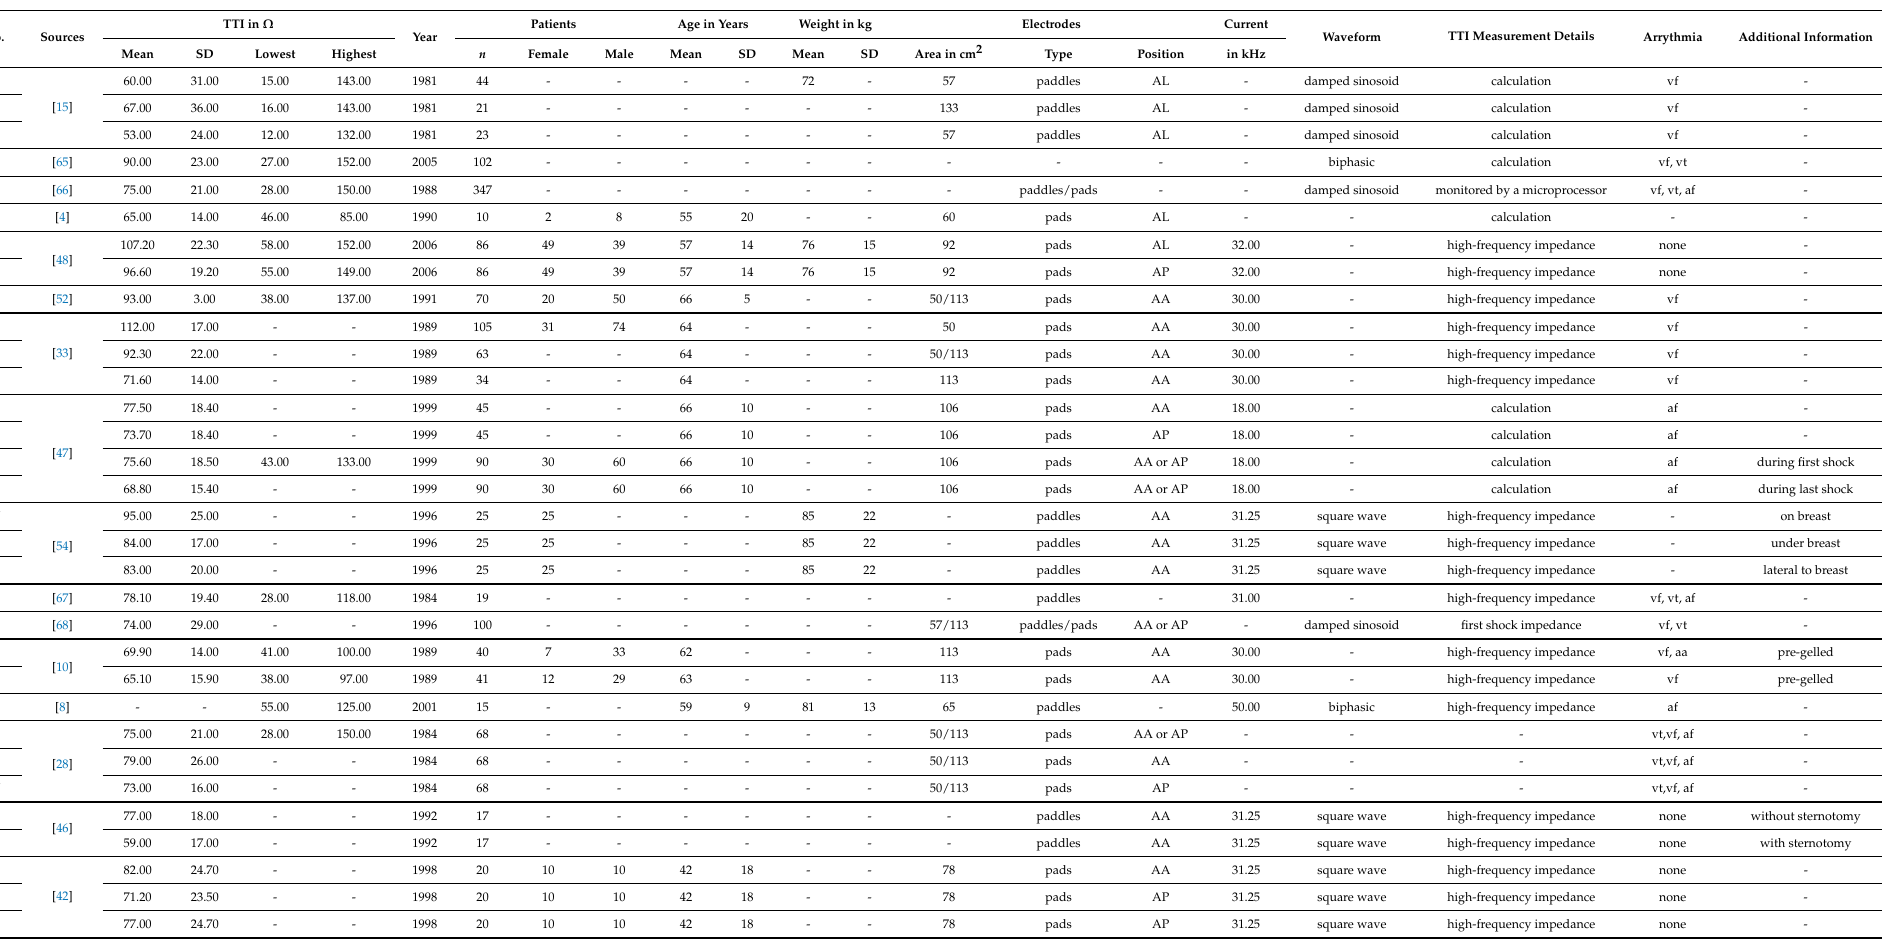
Table A1. TTI measurements from the literature research. Measurements performed in a study and their results are associated with the different measurement con-